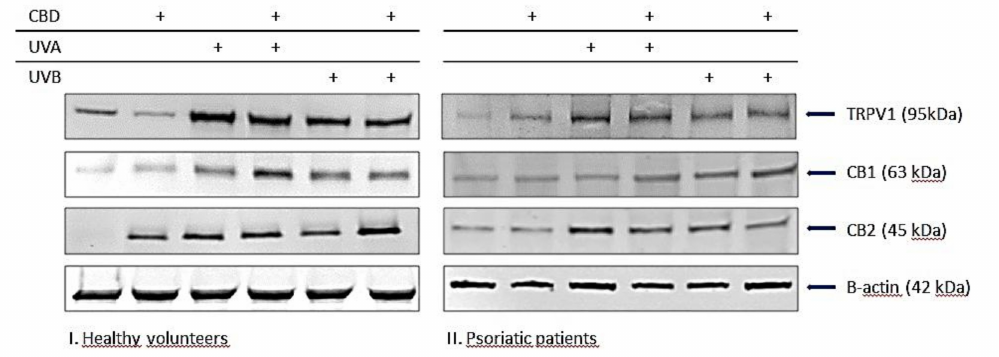
Figure 5. E ff ect of CBD (4 µ M) on endocannabinoid system components: endocannabinoids (anandamide (AEA), 2AG, and palmitoylethanolamide (PEA)), enzymes degrading endocannabinoids (fatty acid amide hydrolase (FAAH) and monoacylglycerol lipase (MAGL)), and receptors activated by lipid mediators (CB1, CB2, TRPV1) in keratinocytes exposed to UVA (30 J / cm 2 ) and UVB (60 mJ / cm 2 ) radiation. The keratinocytes were obtained from healthy subjects (n = 15 for endocannabinoids and degrading enzymes; n = 6 for CB1 / 2 and TRPV1) ( I ) and patients with psoriasis vulgaris (n = 30 for endocannabinoids and degrading enzymes; n = 6 for CB1 / 2 and TRPV1) ( II ) The mean values ± SD are presented with statistically significant di ff erences: a -vs. control / psoriasis group; b -vs. group without CBD; x -psoriasis vs. control group; p < 0.05.